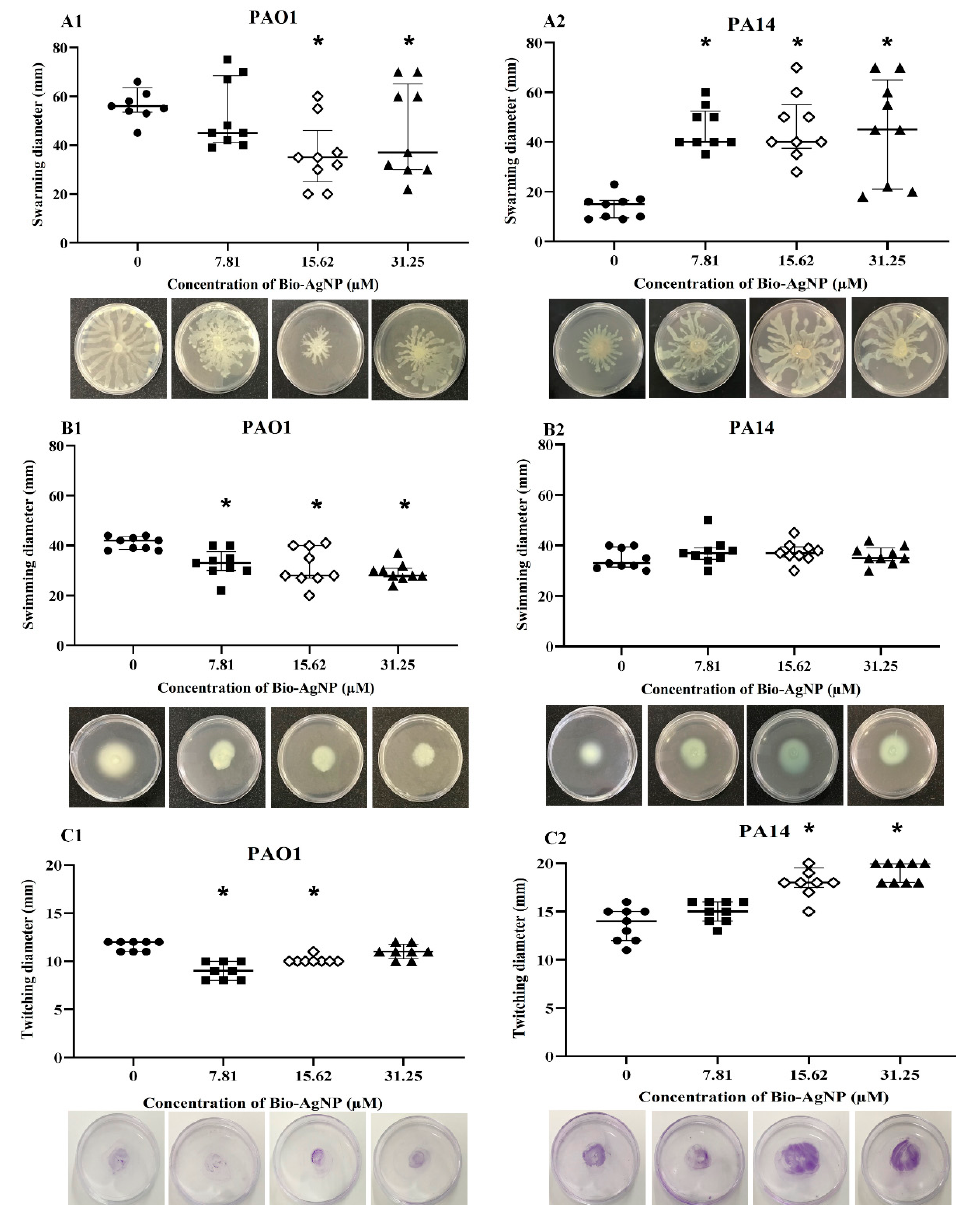
Figure 2. Effect of bio-AgNPs on swarming, swimming, and twitching motilities in Pseudomonas aeruginosa PAO1 and PA14. Swarming motility in ( A1 ) PAO1 and ( A2 ) PA14. Swimming motility in ( B1 ) PAO1 and ( B2 ) PA14. Twitching motility in ( C1 ) PAO1 and ( C2 ) PA14. Each data point represents the result of one treatment, and the mean of three replications is indicated by a black bar. Images below the graphs are representative photographs of PAO1 and PA14 motility halos. Asterisks indicate significant differences between means and the control at p < 0.05 by analysis of variance followed by Tukey’s